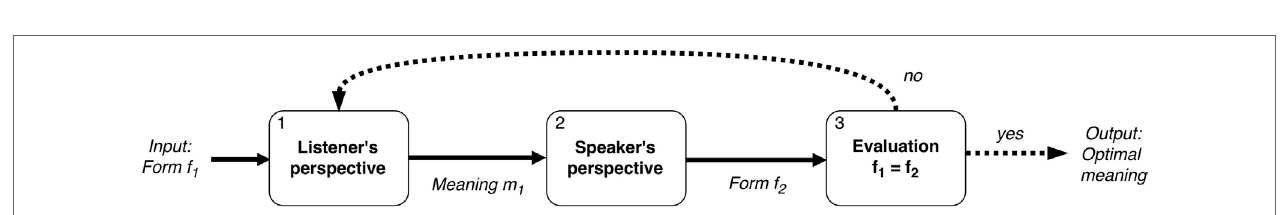
FigURe 7 | An optimization process from the perspective of the listener as well as an optimization process from the perspective of the speaker is performed [based on Van Rij et al.